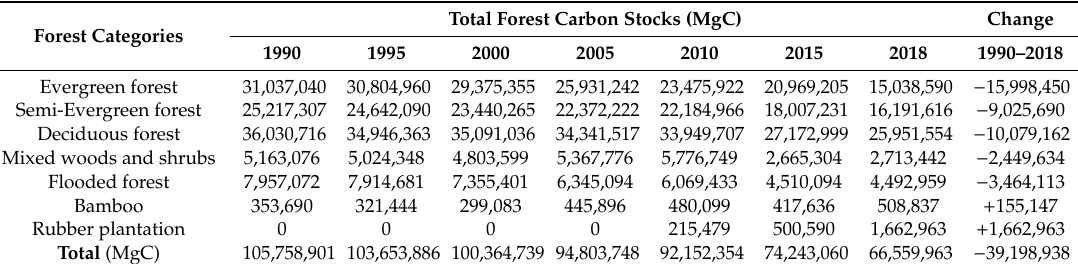
Table 7. Changes in forest carbon stocks by forest category.